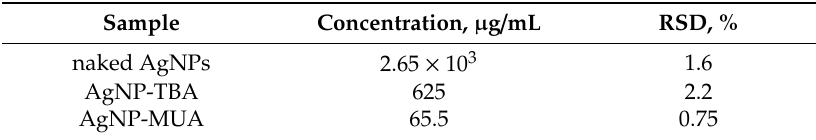
Table 1. Concentrations of Ag ( µ g / mL) in samples *. AgNPs—silver nanoparticles; TBA—thiobarbituric acid; MUA—11-mercaptoundecanoic